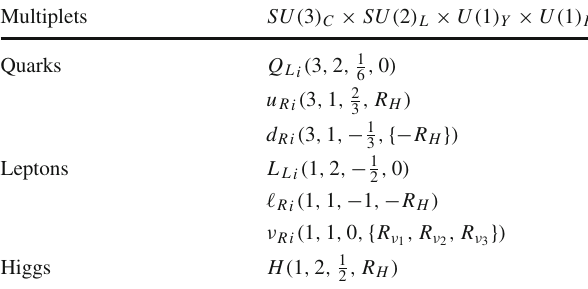
Table 1 Quantum numbers of the fermions and the SM Higgs doublet